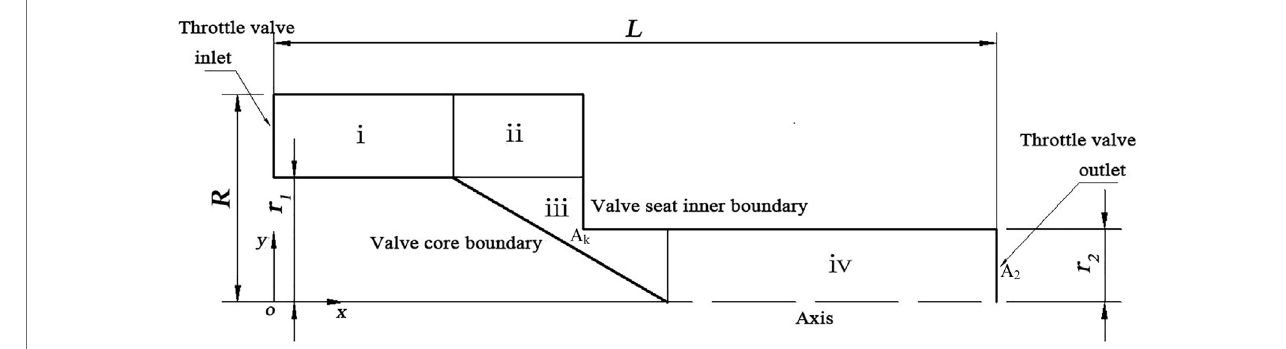
FIGURE 2 | Geometric structure of the cone valve.